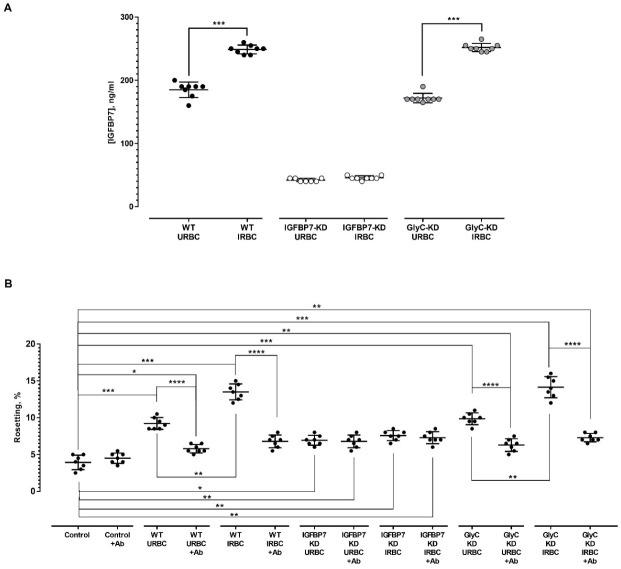
THP-1-derived IGFBP7 and its effect on rosette-stimulation.(A) IGFBP7 secretion level of THP-1 cells of different gene knockdown (KD) status (cell numbers = 3×106). The Mann-Whitney test was used to compare the difference in IGFBP7 secretion levels between URBC- and IRBC-exposed settings for each cell type. For the non-transduced wild type (WT), the IRBC-exposed group secreted more IGFBP7 than their URBC-exposed counterpart (control) (p=0.0002). For the IGFBP7-KD group, exposure to IRBC did not significantly alter the IGFBP7 secretion by the cells, compared to those exposed to URBC (p=0.0678). For the GlyC-KD group, exposure to IRBC also significantly increased the IGFBP7 secretion level by the cells (p=0.0002). A Kruskal-Wallis test was also performed for cross-group comparison. There was no significant difference in level of IGFBP7 secretion between the URBC-exposed WT and GlyC-KD groups (p=0.0624), as well as between IRBC-exposed WT and GlyC-KD groups (p>0.9999). (B) Rosetting challenge assay using culture supernatant of the THP-1 cells (equivalent to that of 1 × 106 cells) with different gene knockdown status. Within each of the seven groups of experimental settings, Welch’s unpaired t-test was conducted to compare the effect of anti-IGFBP7 on rosetting rates. The antibody did not exert significant alteration to the rosetting rates in groups control (exposed to 1XPBS) (p=0.2358), IGFBP7-KD_URBC (p=0.7354), and IGFBP7-KD_IRBC (p=0.4867). The antibody significantly reduced rosetting in groups WT_URBC (p<0.0001), WT_IRBC (p<0.0001), GlyC-KD_URBC (p<0.0001), and GlyC-KD_IRBC (p<0.0001). Cross-group comparison was performed using one-Way ANOVA with Tukey’s test. Relative to the control, higher rosetting rates were recorded in WT_URBC (p=0.0004), WT_URBC+Ab (p=0.0409), WT_IRBC (p=0.0001), IGFBP7-KD_URBC (p=0.0105), IGFBP7-KD_URBC+Ab (p=0.0074), IGFBP7-KD_IRBC (p=0.0016), IGFBP7-KD_IRBC+Ab (p=0.0088), GlyC-KD_URBC (p=0.0007), GlyC-KD_URBC+ Ab (p=0.0038), GlyC-KD_IRBC (p=0.0003), and GlyC-KD_IRBC+Ab (p=0.0047), but not in group WT-IRBC+Ab (p=0.0709).